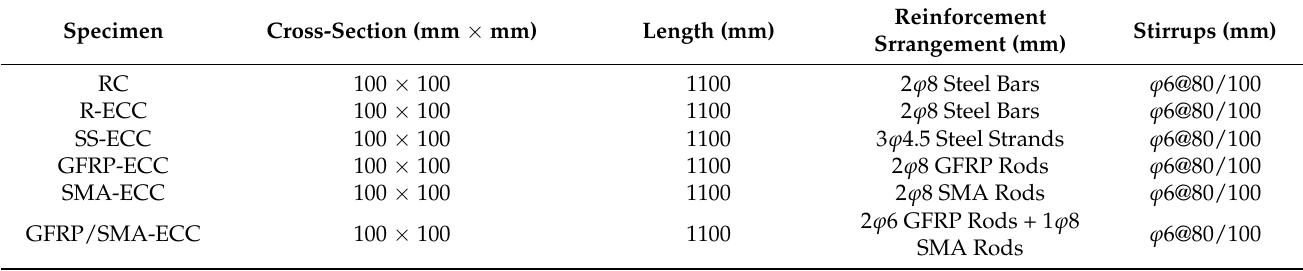
Table 1. Specimens’ geometric